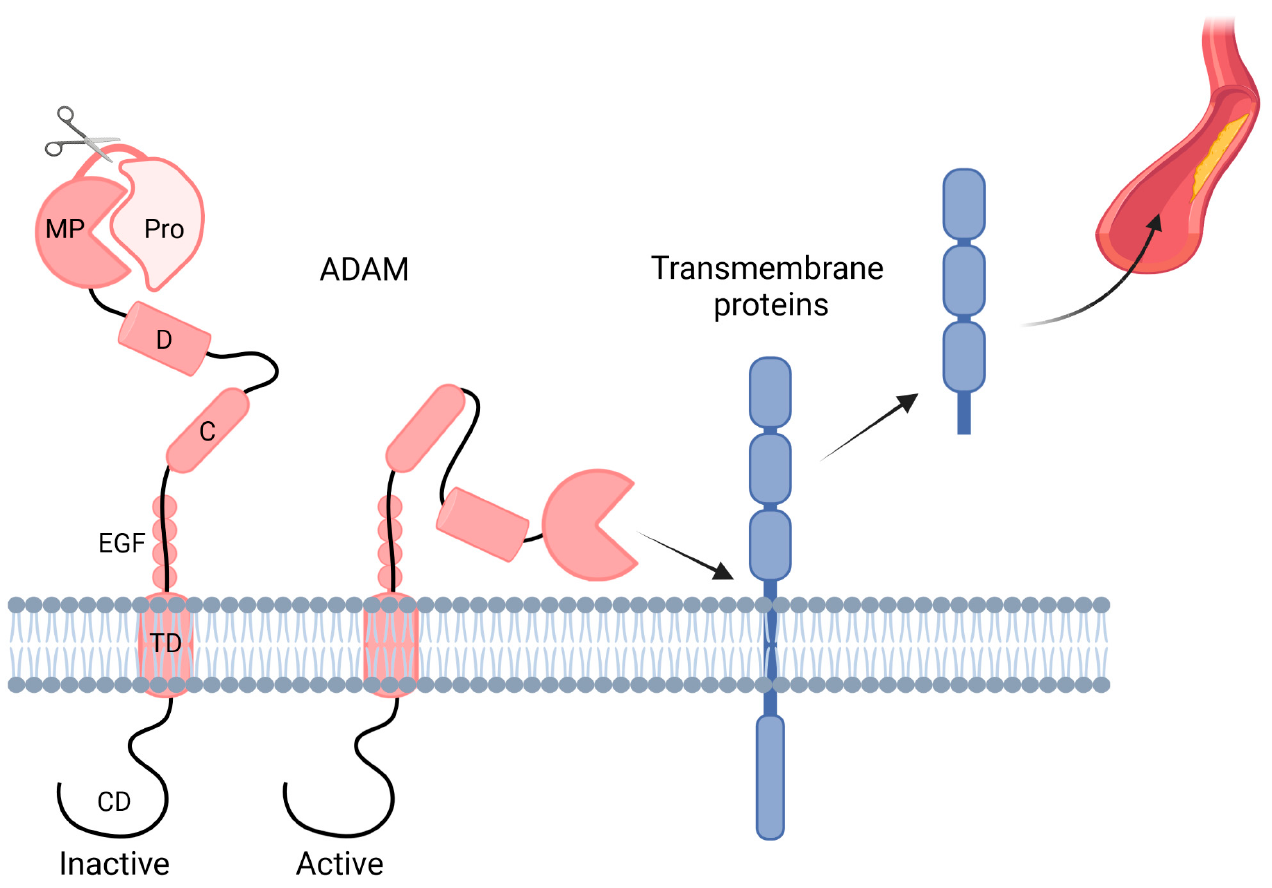
Figure 1. ADAM domain structure. A disintegrin and metalloproteinases (ADAM) present on the transmembrane consists of seven domains, namely the prodomain (pro), metalloprotease domain (MP), disintegrin domain (D), cysteine-rich domain (C), EGF-like domain (EGF; except for ADAM10 and ADAM17), transmembrane domain (TD), and cytoplasmic domain (CD). ADAMs are activated after the prodomain (Pro) is cleaved off, after which they can shed, among others, transmembrane proteins, which are released into the circulation. Created with